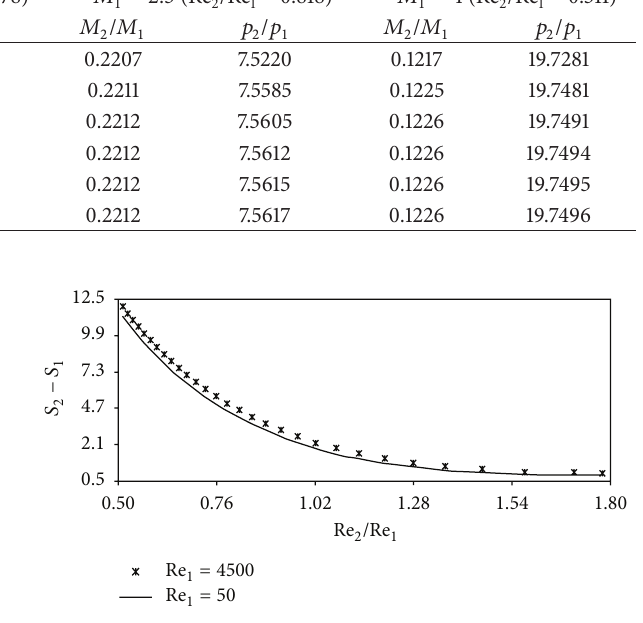
Figure 3: Variations of compression rate with respect to 𝑀 1 for different values of upstream Re.